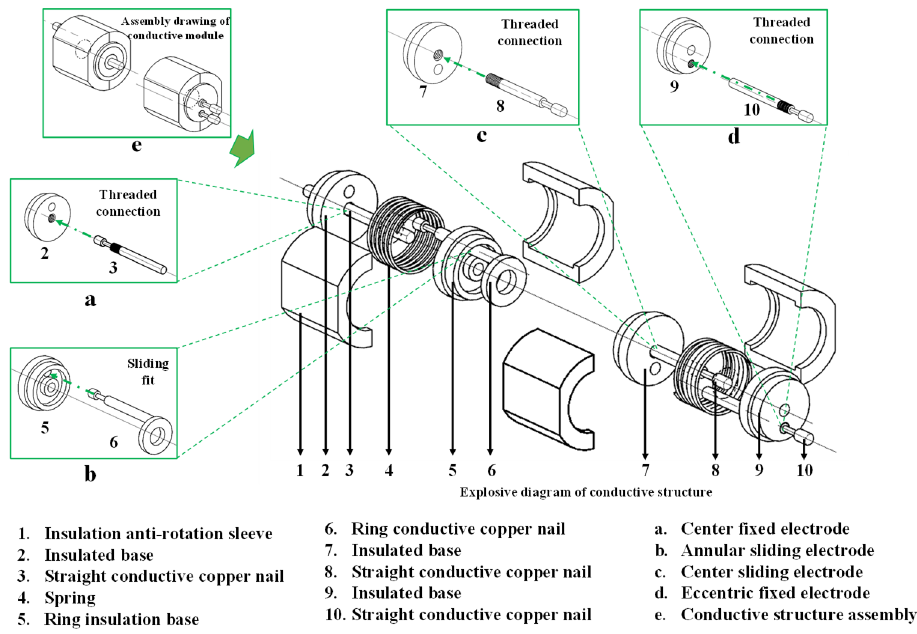
Figure 18. The final optimization design of the conductive center pole structure.